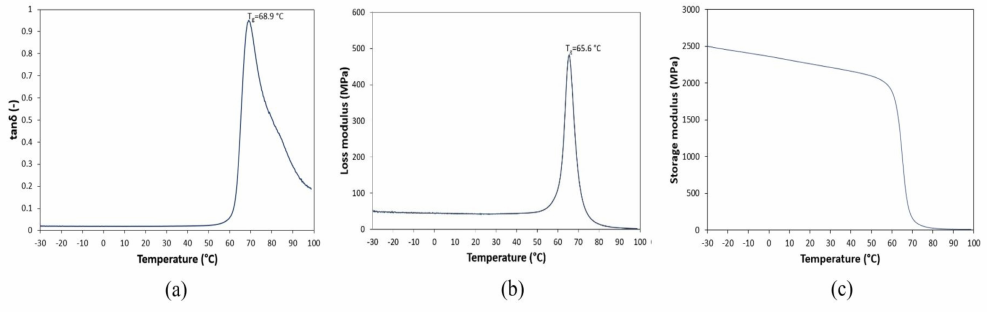
Figure 8. Curves obtained from DMA testing: ( a ) Loss factor (tan δ ), ( b ) loss modulus, ( c ) storage